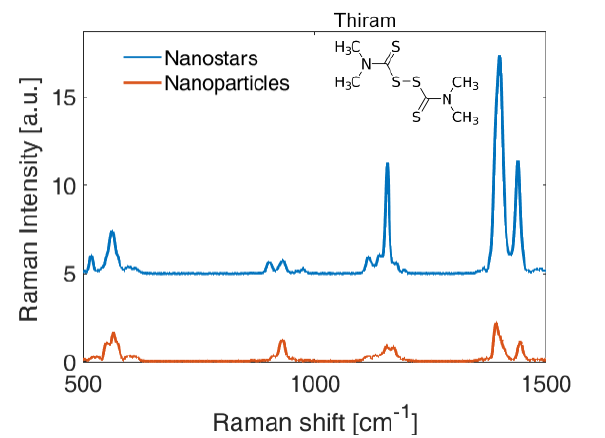
Figure 6. SERS signal and detection of 1 µ M of Thiram in water (240 ppb) for nanostars and nanospheres-based substrates realized with the optimal pressures of respectively 13 mNm − 1 and 10 mNm − 1